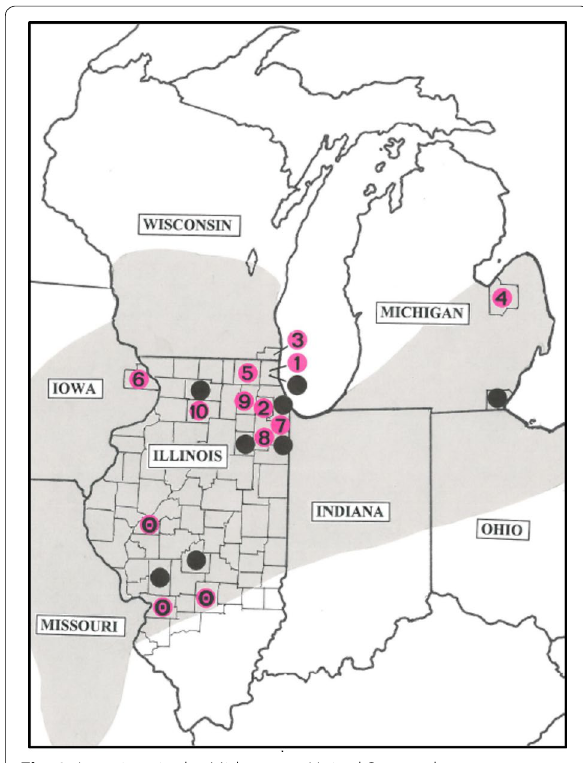
Fig. 2 Locations in the Midwestern United States where Ceratobasidium fungi were isolated from roots and/or protocorms of Platanthera leucophaea as of 2017. The shaded areas reflect the orchid’s historic distribution (Bowles 1983). Solid dots indicate locations where Ceratobasidium ( Ceratorhiza ) was recovered from = P. leucophaea prior to the present study. The two solid dots from lower region of Illinois (Christian and Macoupin Co.) were locations where protocorms of P. leucophaea were acquired from seed packets (see Zettler and Piskin 2011). Pink dots with numbers represent sites where Ceratobasidium was acquired from P. leucophaea in the present study: 1 Lake Co., IL; 2 Dupage Co., IL; 3 Kenosha Co., WI; = = = 4 Tuscola Co., MI; 5 McHenry Co., IL; 6 Jackson Co., IA; 7 Cook = = = = Co., IL; 8 Will Co., IL; 9 Kane Co., IL; 10 Lee Co., IL. Pink dots = = = lacking a number reflect tallgrass prairie sites where Ceratobasidium was isolated from orchids other than P. leucophaea (i.e., Platanthera lacera , P . peramoena , Spiranthes magnicamporum , S. vernalis